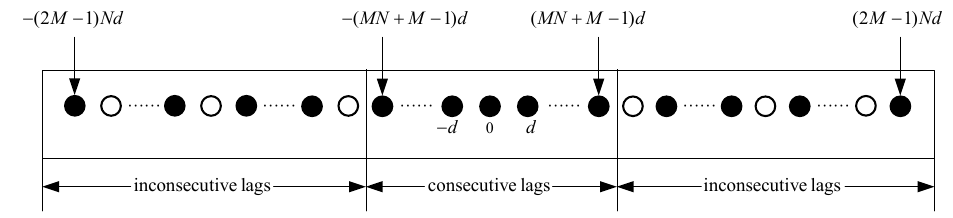
Figure 2. The difference coarray of coprime array.